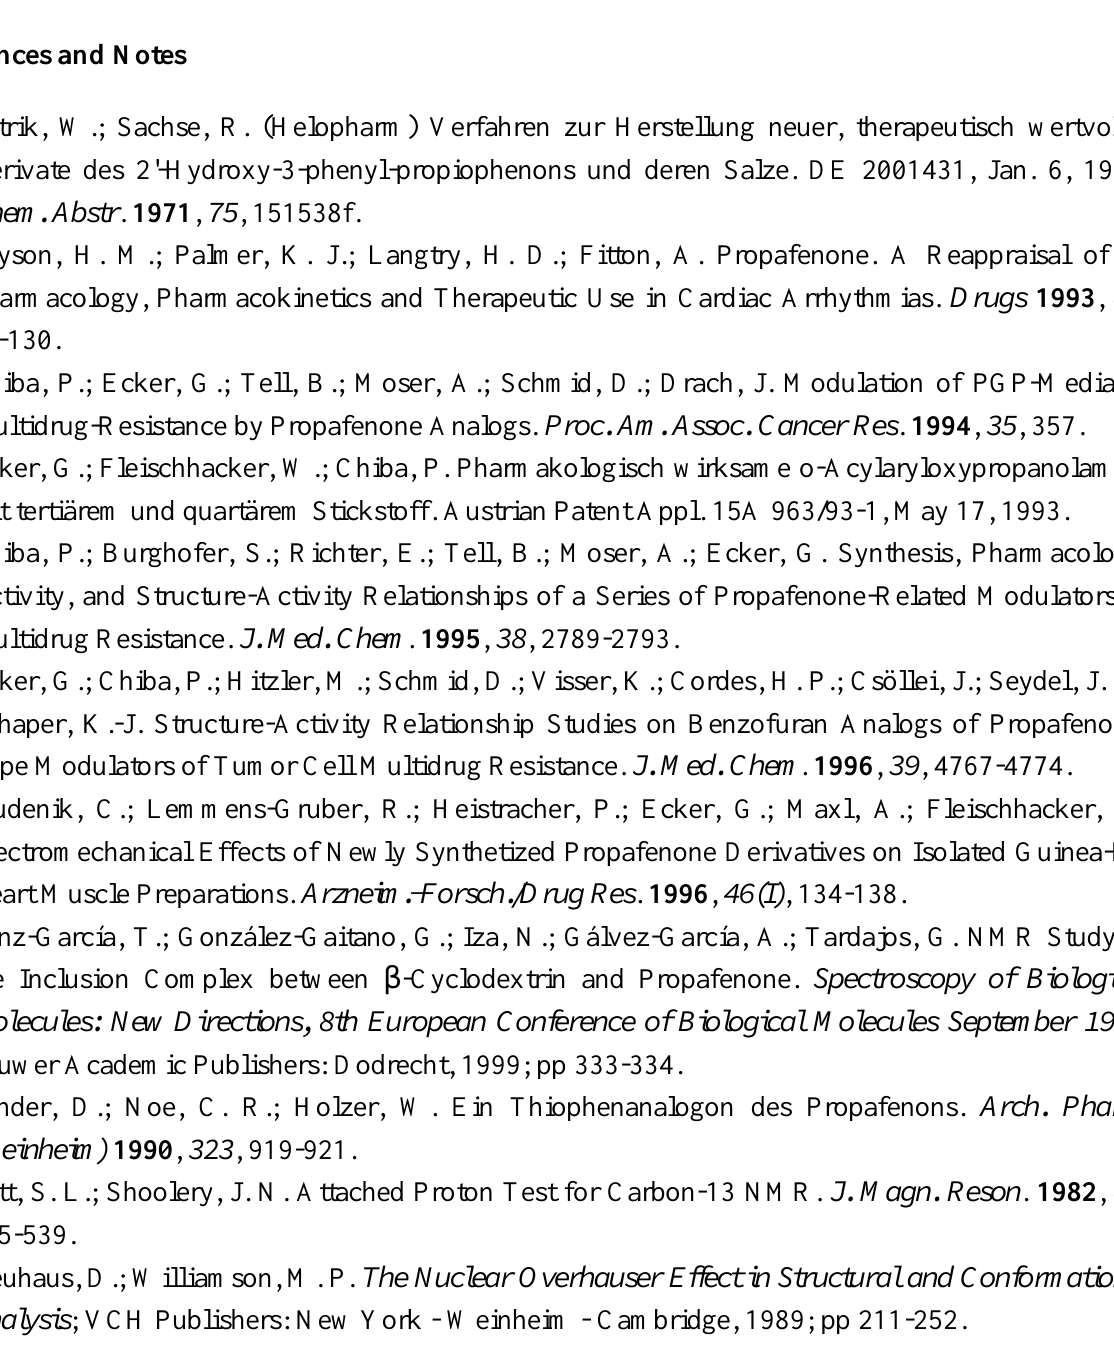
Selected 2 and 2(cid:127)HCl Coupling